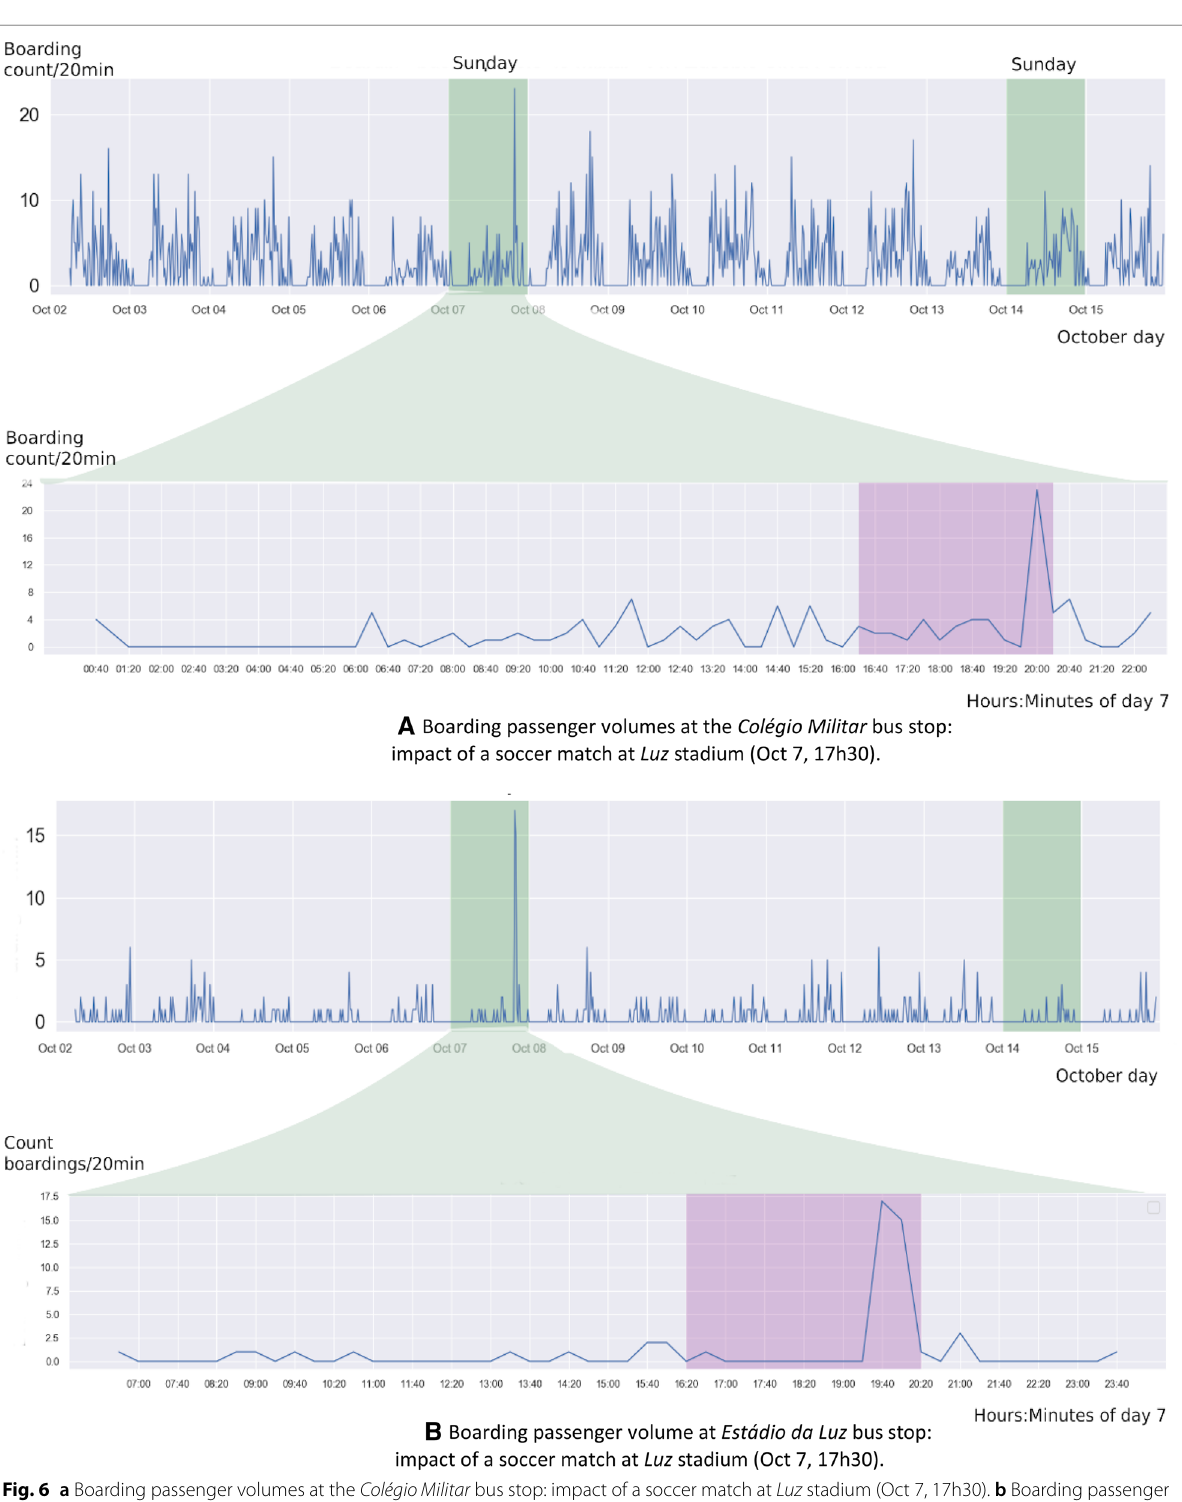
Fig. 6 a Boarding passenger volumes at the Colégio Militar bus stop: impact of a soccer match at Luz stadium (Oct 7, 17h30). b Boarding passenger volume at Estádio da Luz bus stop: impact of a soccer match at Luz stadium (Oct 7,